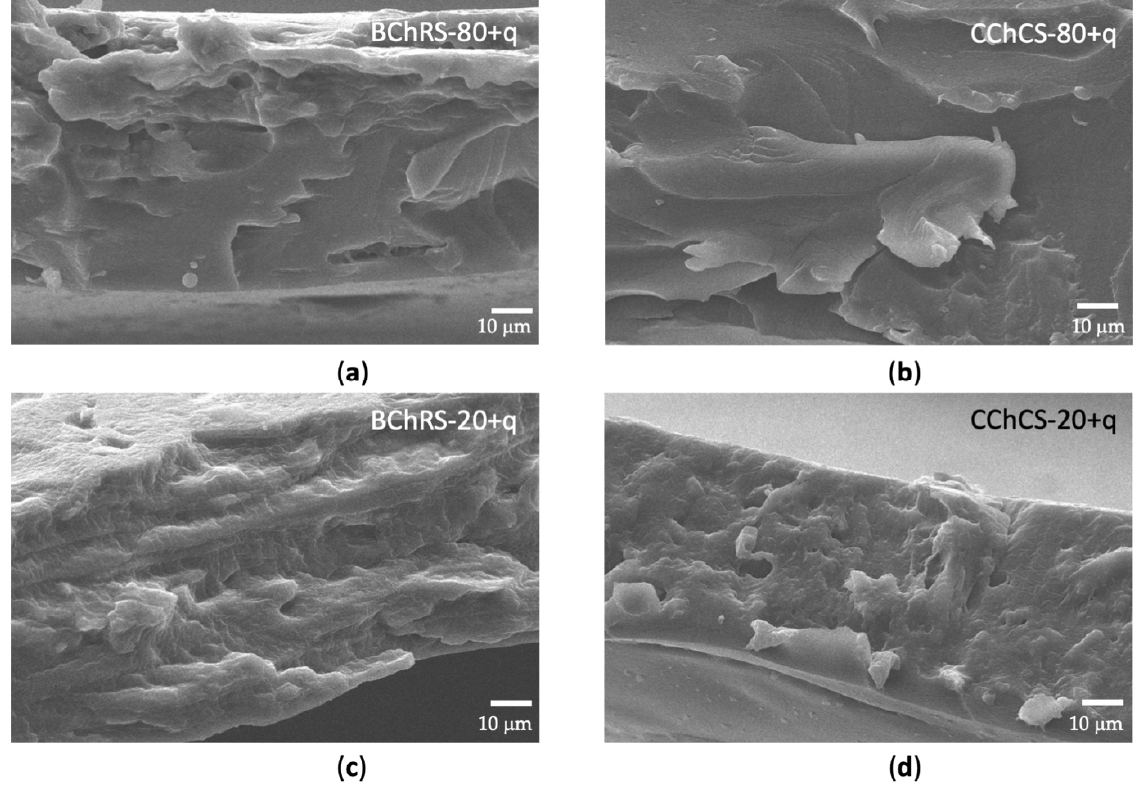
Figure 5. SEM micrographs of ( a ) BChRS-80+q, ( b ) CChCS-80+q, ( c ) BChRS-20+q and ( d ) CChCS- 20+q films. 20+q